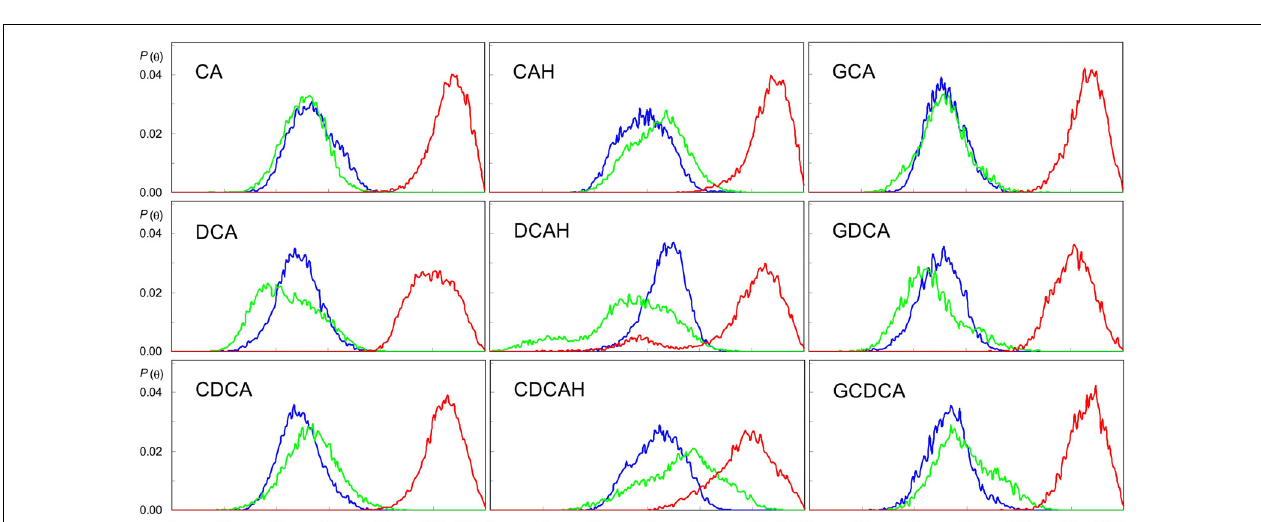
FIGURE 3 | Average location of selected POPC (dashed horizontal lines; please refer to Figure 1 for numbering) and BS atoms (vertical bars) during the simulations (see Figure 1 for atom numbering).